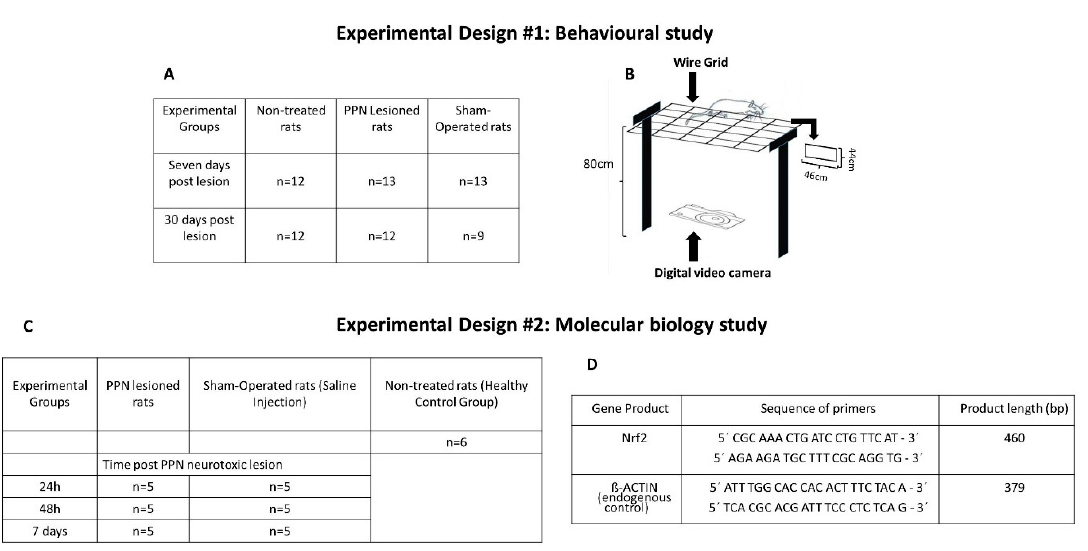
Figure 2. Main details of each experimental design (number of rats in each experimental group, set details, etc.). ( A ) Number of samples of each experimental group participating in the behavioral study. ( B ) Diagram of the grid apparatus and experimental set. Note the rectangular shape (46 × 44 cm) of the grid holes and the placement of a digital video camera that allows the moving image of the rat to be taken from a ventral position. ( C ) Number of samples of each experimental group participating in the molecular biology study. ( D ) Sequence of primers for RT ‐ PCR.